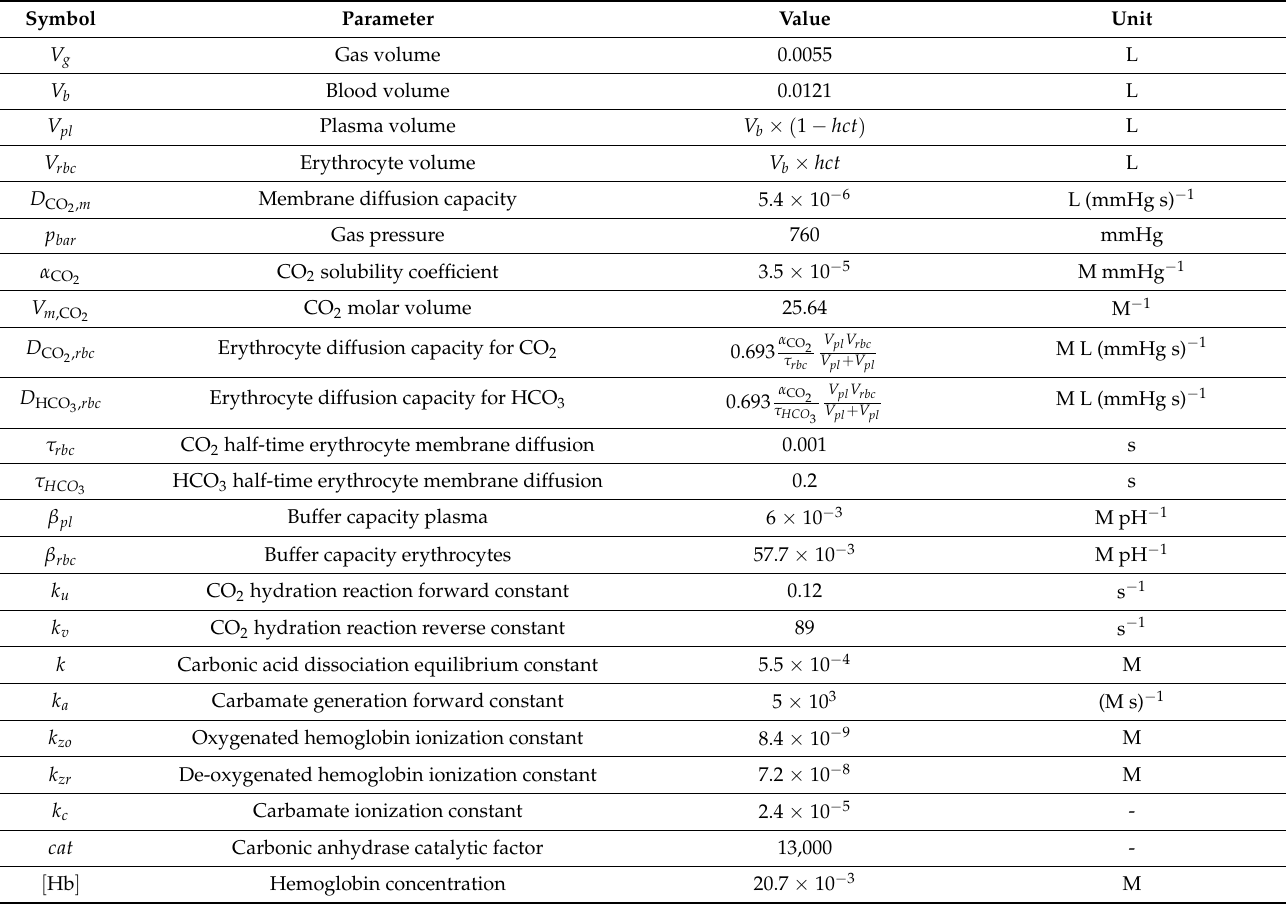
Table A2. Summary of model